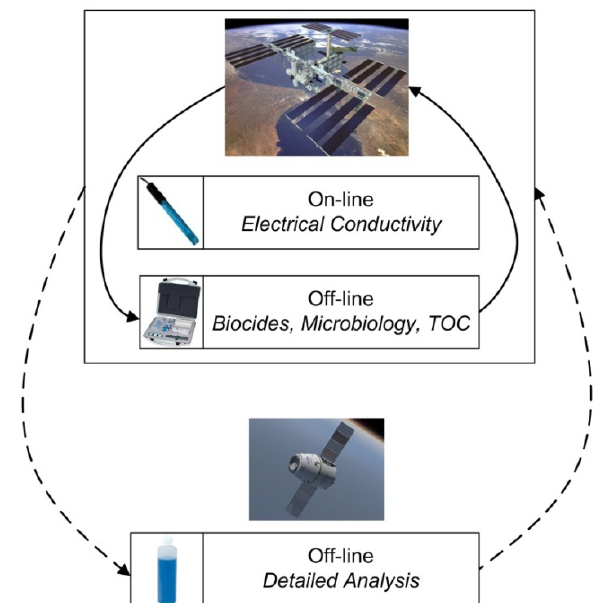
Figure 11. Current ISS water monitoring capabilities (US Orbital Segment). On-line monitoring of EC exists within the Water Processor Assembly. TOC analysis can be conducted in an on-line manner through the TOCA directly piped into the water system and conducted on an approximately weekly basis. Other off-line analyses can be conducted on-orbit utilizing water test-kits for detection of biocides and microbiology. Detailed analysis is also conducted on an infrequent basis with ground returned